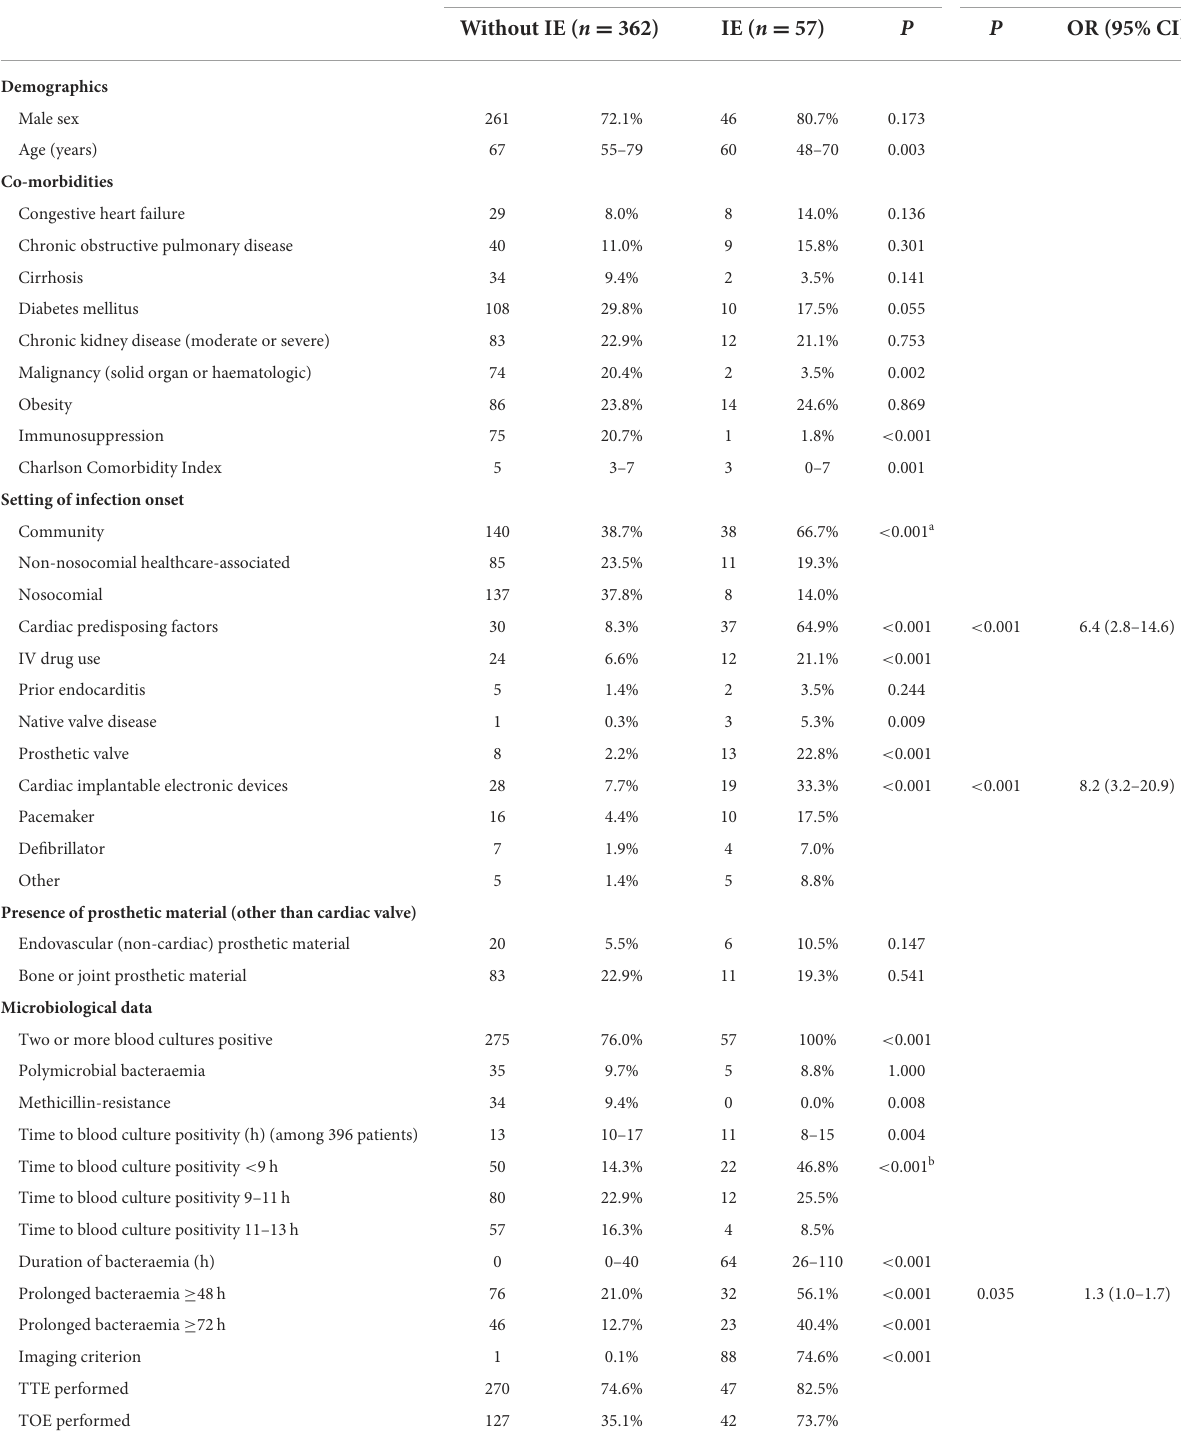
TABLE 1 Predictors of definite infective endocarditis (according to the 2015 ESC-modified Duke Criteria) in patients with S. aureus bacteremia in the derivation cohort. Univariate analysis Multivariable